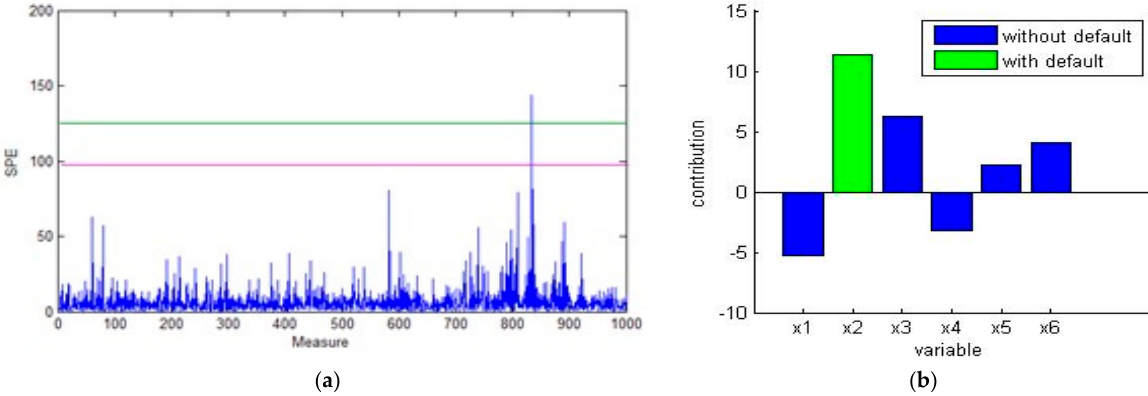
Figure 6. SPE fault detection ( a ) and isolation ( b ) of reconstructed data using the neural PCA.